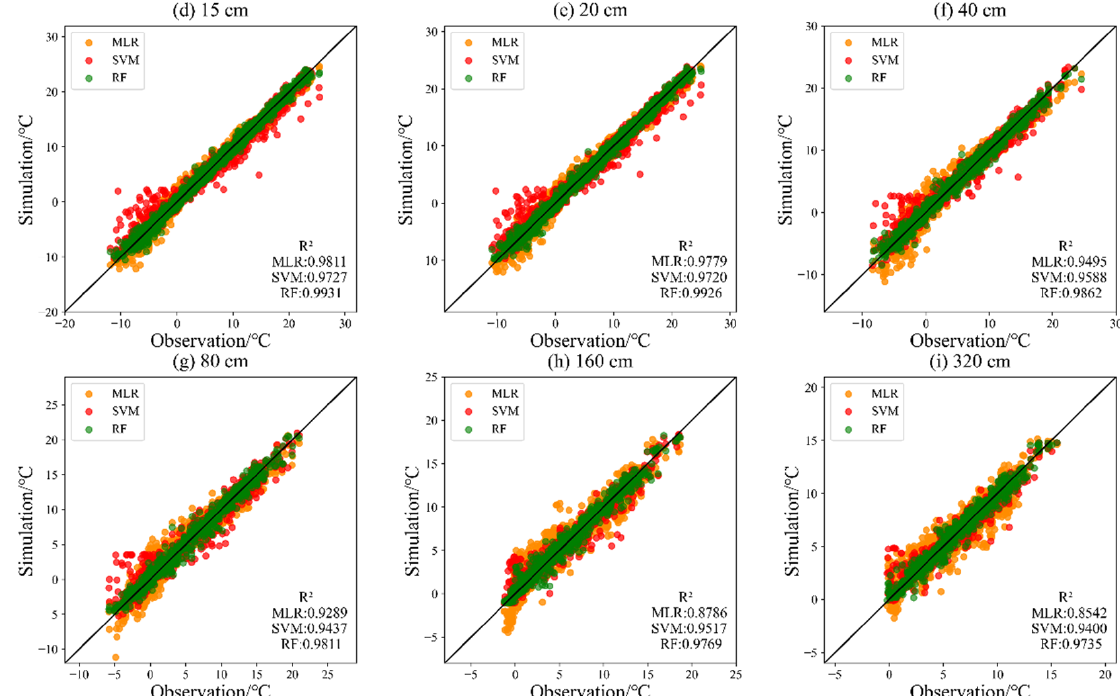
Figure 2. Observation ‐ simulation comparison of MLR, SVM, and RF models at ( a ) 0 cm, ( b ) 5 cm, ( c ) 10 cm, ( d ) 15 cm, ( e ) 20 cm, ( f ) 40 cm, ( g ) 80 cm, ( h ) 160 cm, ( i ) 320 cm.